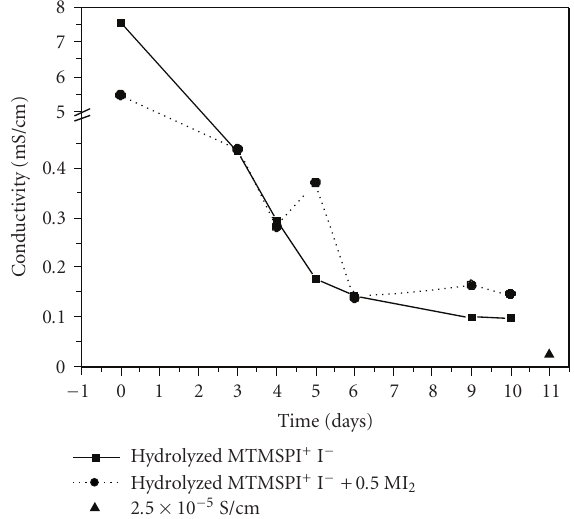
Figure 8: Changes of the specific conductivity of hydrolyzed (0 . 1M HCl) MTMSPI + I − (closed squares, solid line) and hydrolyzed MTMSPI + I − + 0 . 5M I 2 (closed circles, dotted line) with the dura- tion of ageing. σ value of the MTMSPI + I − + 0 . 5M I 2 heat treated at 200 ◦ C (closed